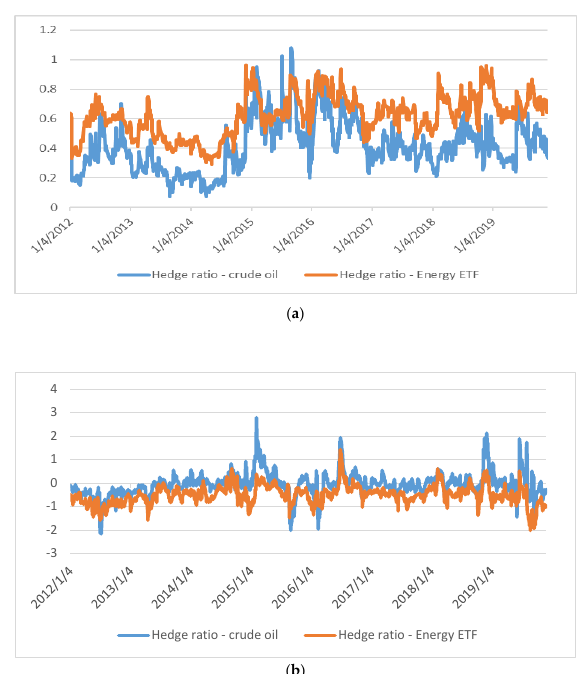
Figure 2. ( a ) Dynamic hedge ratio between the clean energy stock index and each of the two dirty energy assets. Source: Authors’ calculation. ( b ) Dynamic hedge ratio between the green bond index and each of the two dirty energy assets. Source: Authors’ calculation.